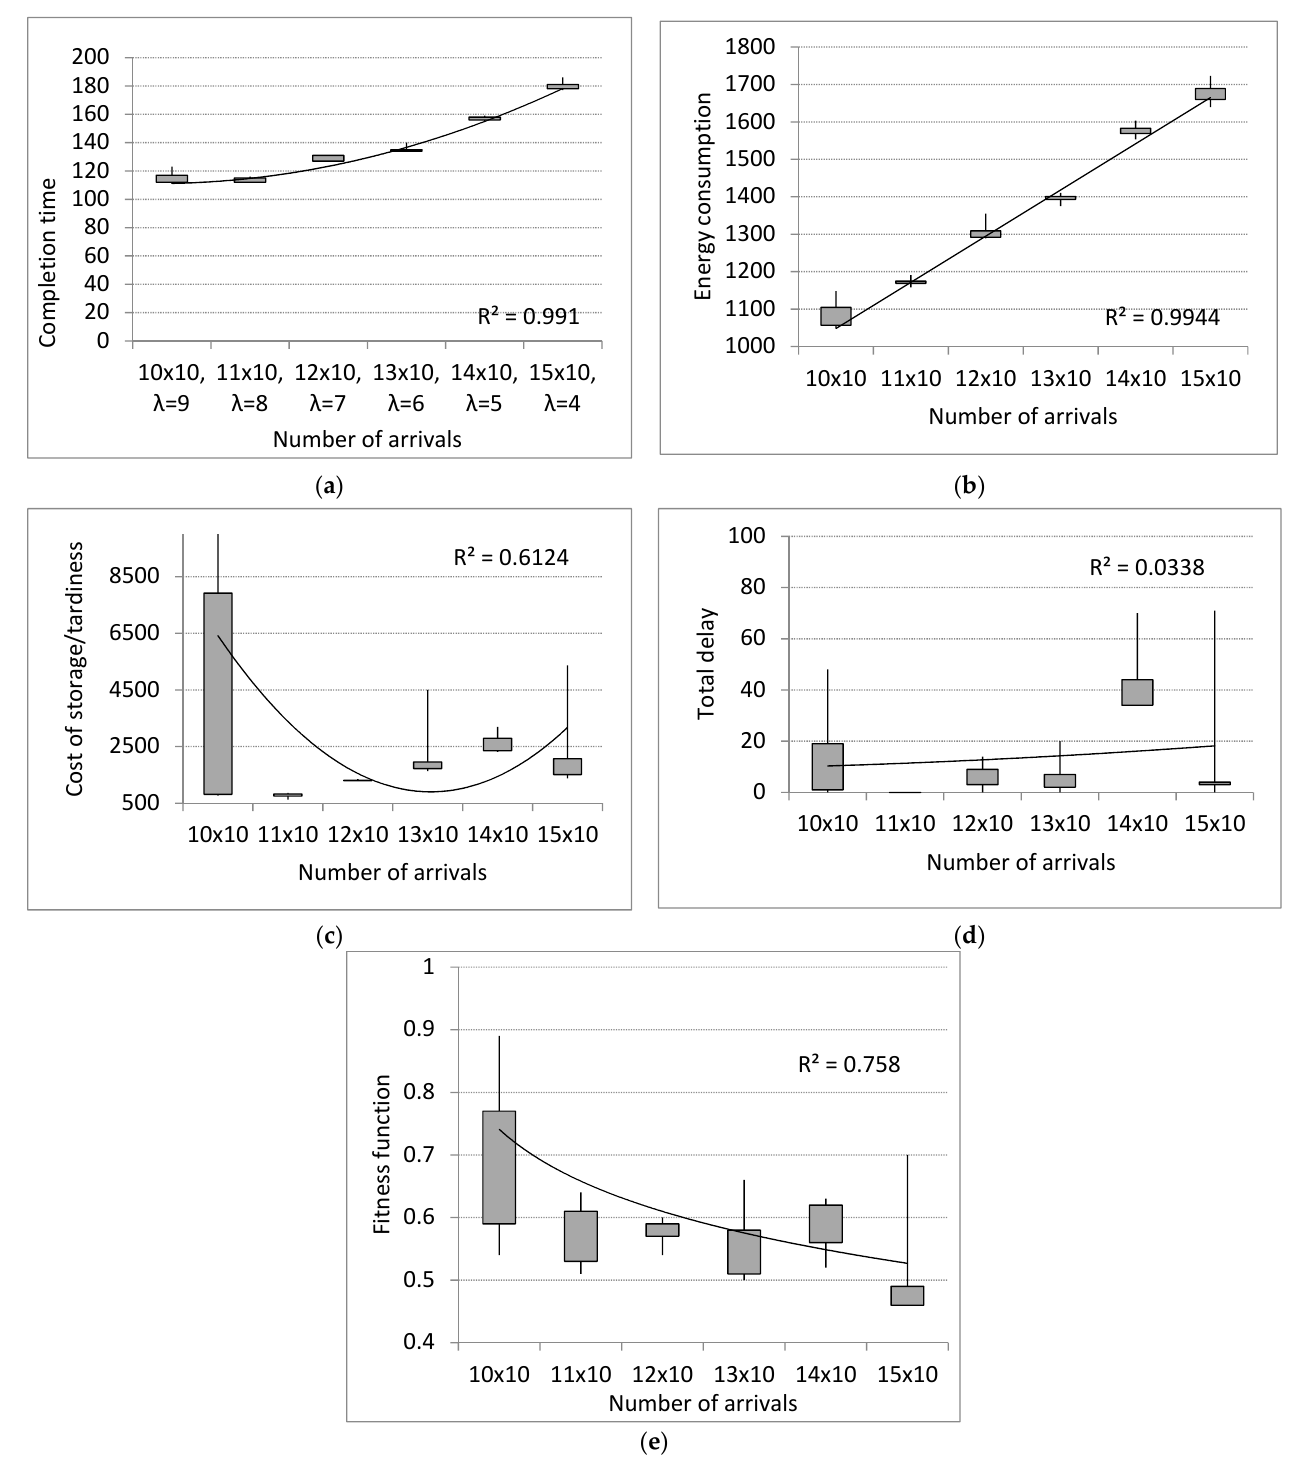
Figure 16. The influence of arrival intensity on ( a ) makespan, ( b ) cost of energy consumption, ( c ) cost of tardiness or premature execution, ( d ) total delay of tasks, ( e ) scalar fitness function for the serial–parallel flow.